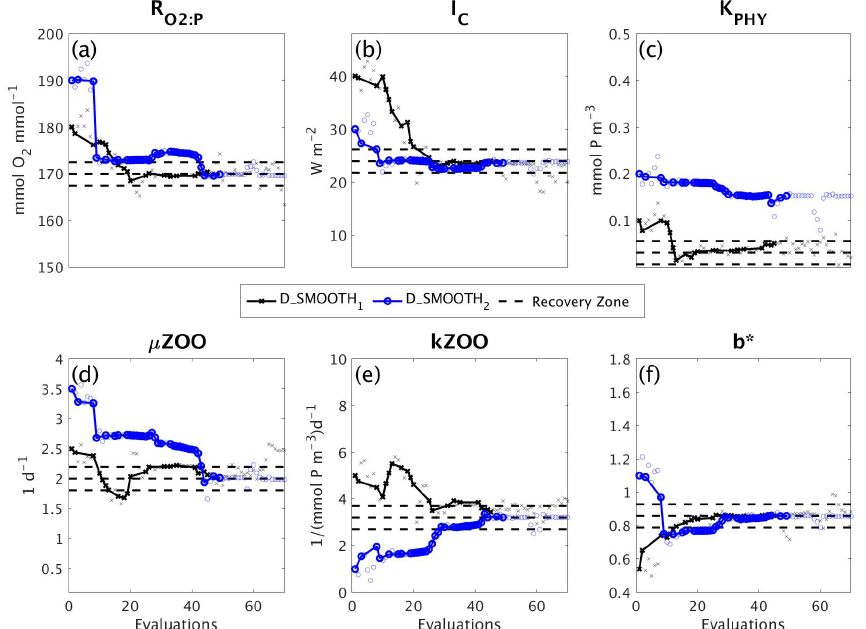
Figure 9. Parameter tuning by DFO-LS for the experiments D_SMOOTH 1 (black line with crosses) and D_SMOOTH 2 (blue line with circles) for the parameters (a) R O , (b) I C , (c) K PHY , (d) µ ZOO , (e) k ZOO and (f) b ∗ . Also plotted are the MOPS-ref target parameter 2 : P values and ± 5% recovery zone (horizontal black dashed lines). Note that every MOPS evaluation has been plotted with a small marker; however, only MOPS evaluations which resulted in a lower misfit than previously seen in each optimisation experiment have been plotted with a solid line.